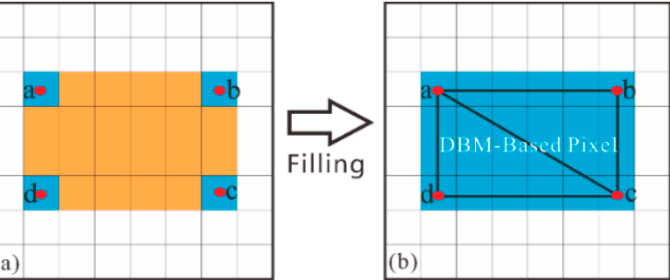
Figure 3. Assigning an elevation value to the building’s roof. ( a ) Before the elevation value is filled; ( b ) After the elevation value is filled, where a, b, c and d represent corner of DBM.